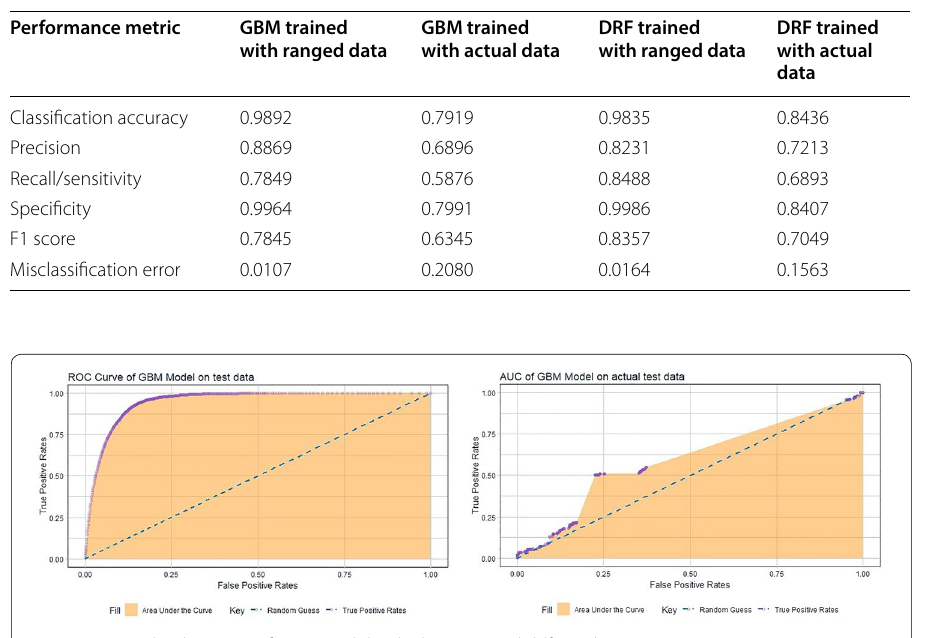
Fig. 7 Area under the curve of GBM models which are trained